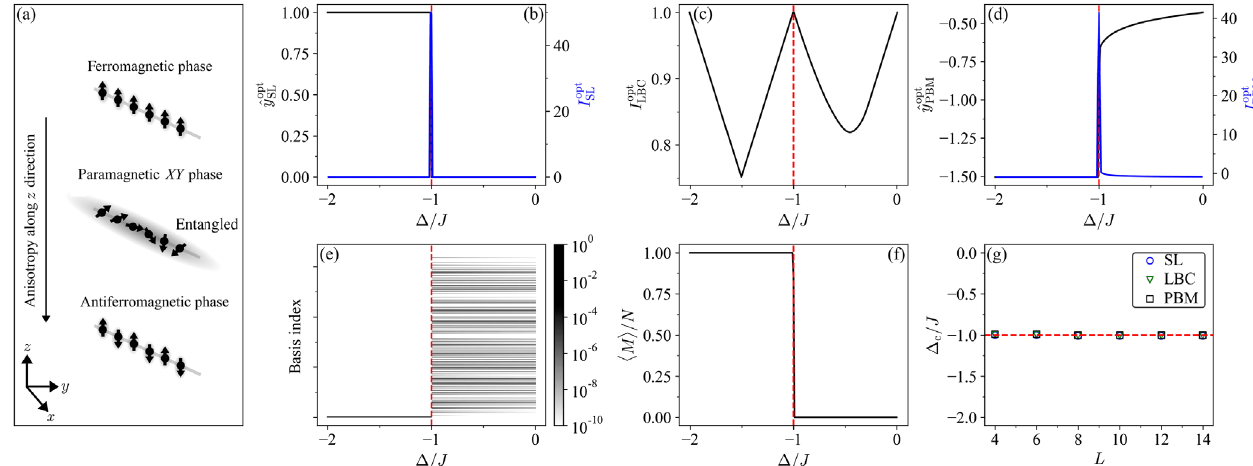
FIG. 6. Results for the XXZ chain ( L ¼ 14 ) with the dimensionless anisotropy strength along the z direction as the tuning parameter 0 , and Δ p ¼ 0 . 01 . In SL, the data obtained at p 1 and p ¼ Δ =J , where p 1 ¼ − 2 , p 1 and p K constitute our training set, i.e., r I ¼ K ¼ l K . The critical value of the tuning parameter Δ =J ¼ − 1 at which the phase transition between the ferromagnetic phase and II ¼ paramagnetic XY phase occurs is highlighted by a red dashed line. (a) Illustration of the quantum phase transitions of the XXZ chain. (b) Mean optimal prediction ˆ y opt in SL (black line) and the corresponding indicator I opt (blue line). (c) Optimal indicator of LBC, I opt SL SL LBC (black line). (d) Mean optimal prediction ˆ y opt in PBM (black line) and the corresponding indicator I opt (blue line). (e) Probability PBM PBM distributions governing the input data (indices of S z basis states) as a function of the tuning parameter, where the color scale denotes the probability. The color scale is cut off at 10 − 10 to improve visual clarity. (f) Average magnetization per site (black line), where N ¼ L . (SL), I opt (LBC), and I opt (PBM) as a function of the chain length L (g) Estimated critical value of the tuning parameter based on I opt PBM SL LBC